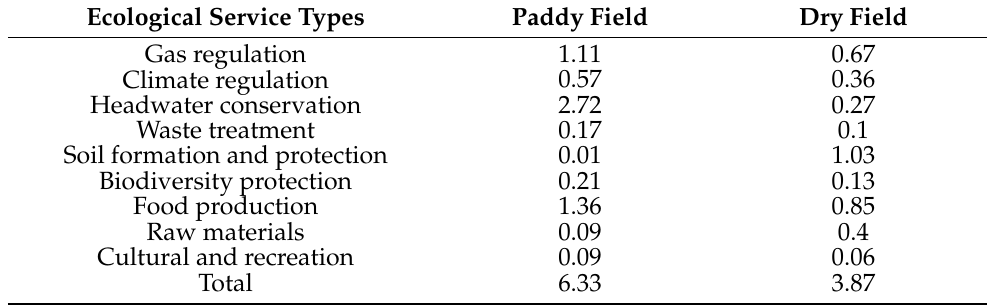
Table 4. Equivalent value per unit area of cropland ecosystem services in China (2011).